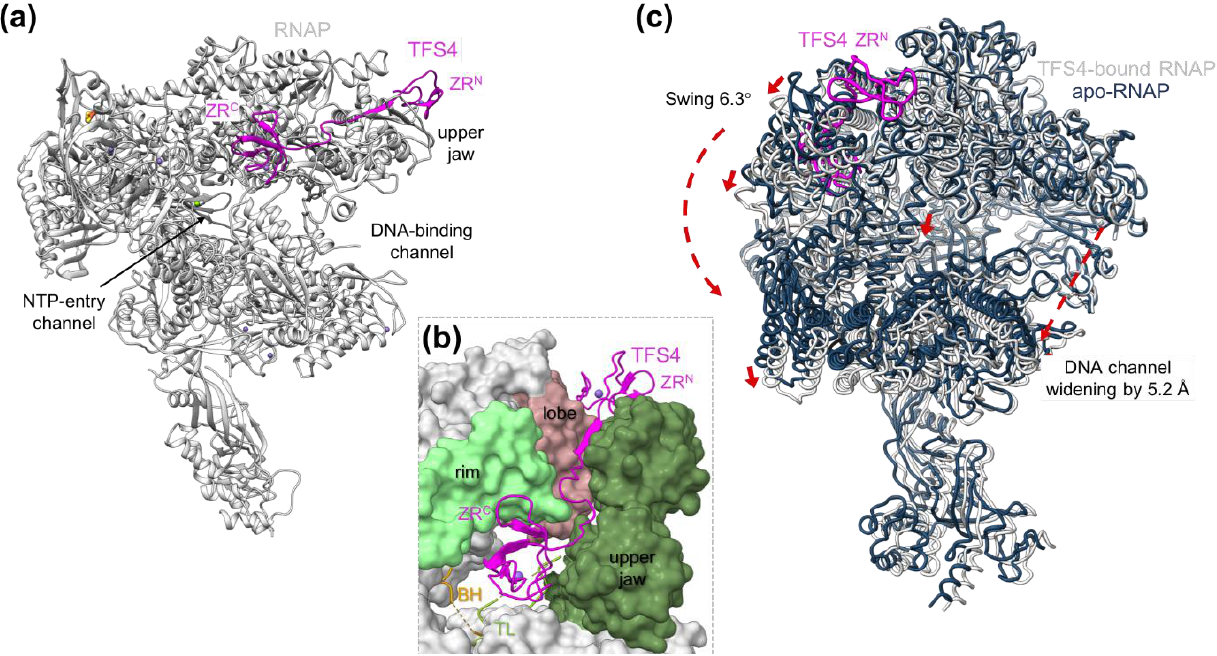
Figure 3. Molecular mechanisms of TFS4 inhibition. ( a ) Cryo-EM structure of the RNAP–TFS4 complex (pdb 7oqy) in ribbon style with ions as spheres, zinc in medium purple, magnesium in green, iron in red, and sulphur in yellow. TFS4 is shown in magenta with the N- and C-terminal zinc ribbon domains indicated. ( b ) Enlargement of the TFS4 binding site shown as surface with the lobe in dark pink, the upper jaw in olive, and the rim helices in light green, while bridge helix, BH in gold, trigger loop, TL in lime, and TFS4 are in ribbon style. Zinc ions are displayed as spheres in medium purple. ( c ) Superimposition of the TFS4–RNAP complex (in grey) with the apo-RNAP (in dark blue from pdb 7ok0). The red arrows indicate the direction of the downwards swinging of the jaw and clamp, as well as the stretch of the bridge helix and the extent of the DNA-binding channel opening.